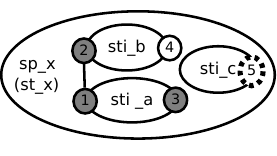
Figure 11: An example of